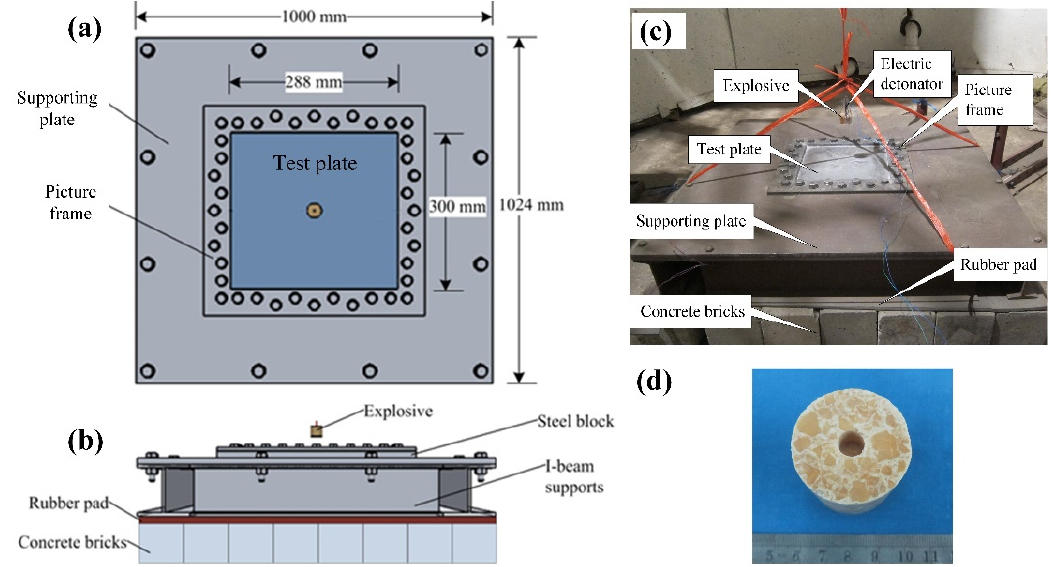
Figure 5. ( a ) Top view and ( b ) side view of a schematic of the clamping and supporting structures; ( c ) a photograph of the test set-up just prior to detonation; ( d ) picture of the cylindrical TNT charge. Table 3. Detailed information regarding the experimental results for polyurea-coated steel plates in the present